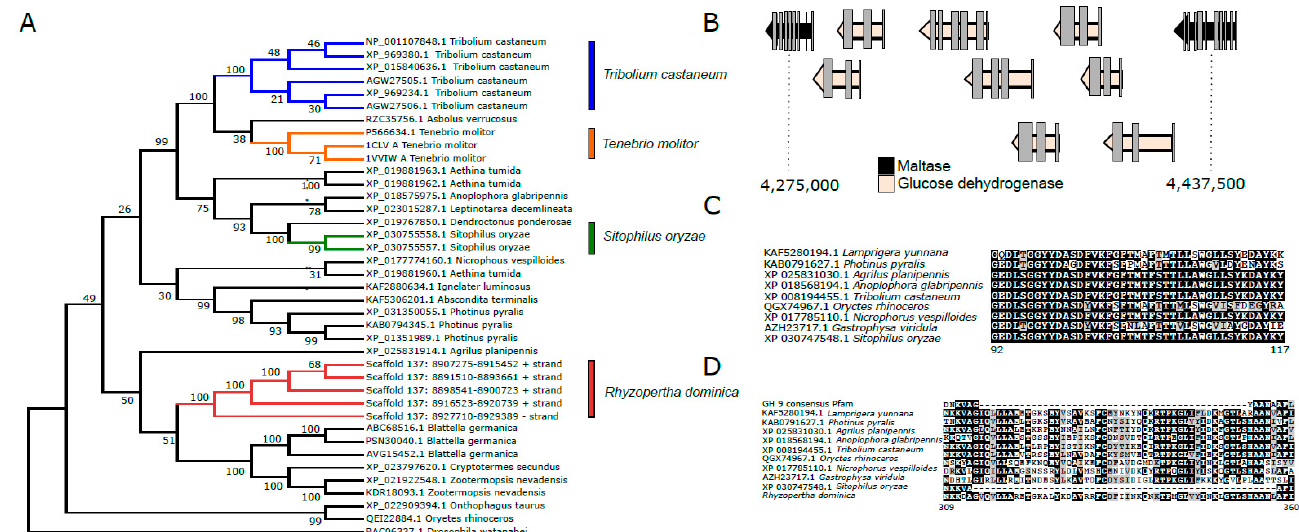
Figure 6. Carbohydrases present in the genome of Rhyzopertha dominica . ( A ). Neighbor-joining tree of α -amylases in R. dominica and in the genomes of other beetles. Sequences with >40% similarity to those annotated in R. dominica were downloaded from NCBI for phylogenetic analysis. Proteins were aligned with MUSCLE in MEGA X, and a bootstrap consensus tree was constructed using 500 bootstrap pseudoreplicates. Evolutionary distances were computed using the JTT distance matrix, and rate variation was modeled with a gamma distribution (shape parameter = 1). Accession numbers of proteins used in the tree are presented, and numbers on nodes indicate bootstrap support. ( B ). An expansion of glucose dehydrogenases on scaffold 4 in R. dominica . An array of 10 gene models for glucose dehydrogenases was found between two maltase genes. Although similar arrays of glucose dehydrogenases can be found in the genomes of other beetles, none were flanked by maltase gene models. Whether adjacent models can be used to infer putative gene function has not yet been widely investigated in insect genomes. ( C ). A deletion in a gene model coding for a GH 9 enzyme in R. dominica . One gene coding for a putative GH 9 enzyme was identified in the R. dominica genome. However, an ~25-amino-acid deletion was noted relative to other beetle endoglucanses, suggesting it may have a different function. ( D ). An insertion in a gene model coding for a putative GH 9 enzyme in all beetles genomes. A large ~50-amino-acid insertion was observed in all sequenced beetles relative to the consensus Pfam sequence. Notably, although many GH 9 gene models code for endoglucanses, many beetle GH 9 enzymes are thought to have different substrate preferences. This large insertion suggestions that these enzymes may no longer act on cellulose and may have different functions even in wood-feeding insects, such as Anoplophora glabripennis